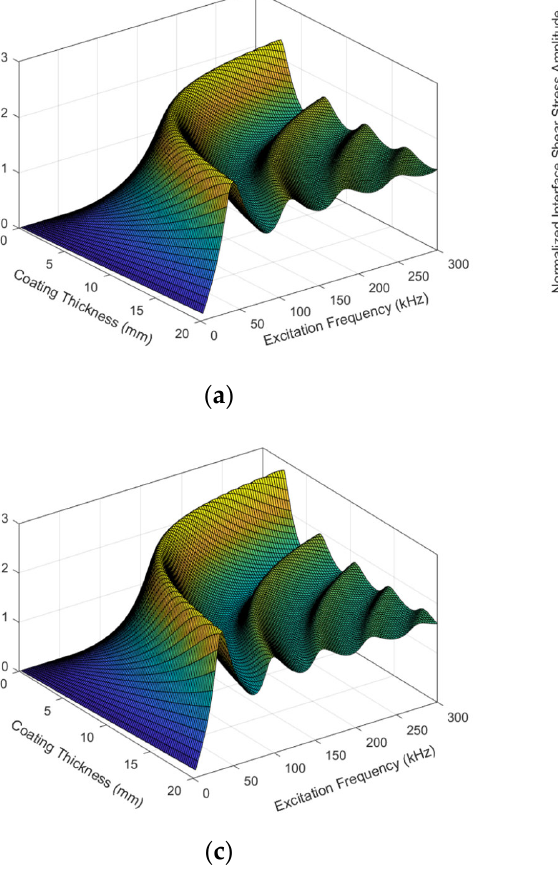
Figure 5. The normalized amplitude of interfacial shear stress in the excitation frequency domain and the coating thickness domain when the substrate is aluminum and the coating is glaze ice ( a ), rime ice ( b ) and frost ( c ).